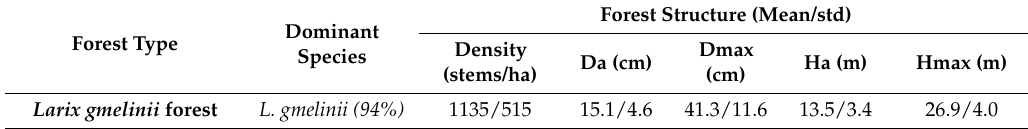
Table 1. Description on the forest in the Genhe old growth primary forest region